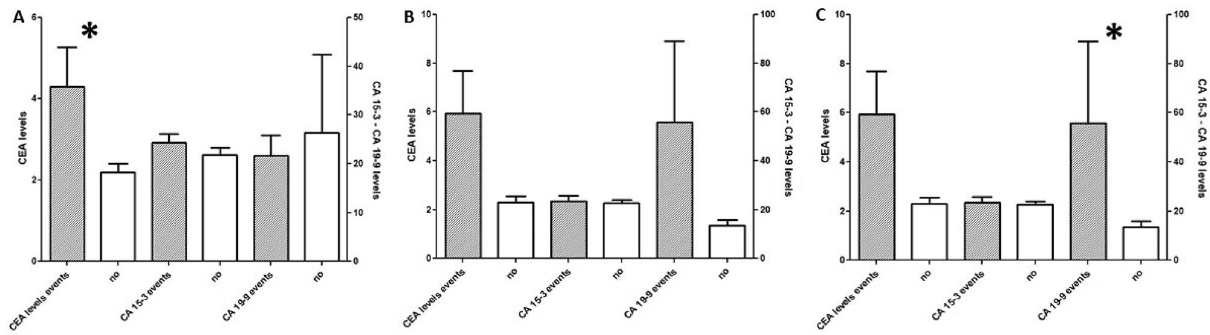
Figure 1. Serum levels of CEA, CA15-3 and CA-19-9 during hospitalization according to incidence of adverse events during hospitalization. * p <